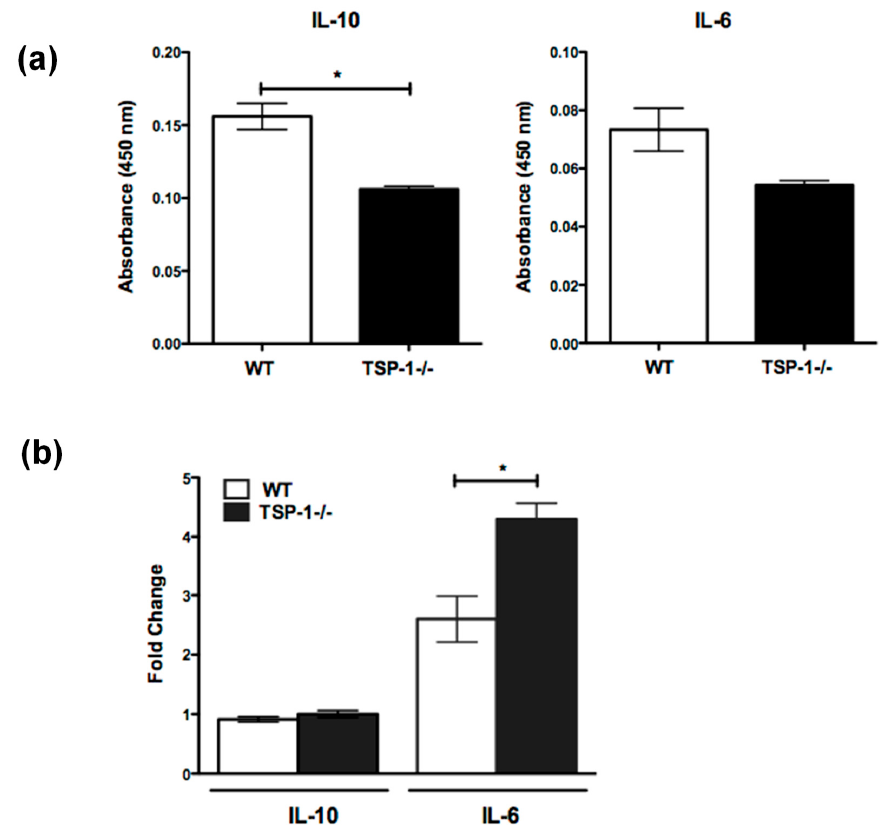
Figure 4. Cytokine secretion by MZB cells from TSP1 − / − mice is altered. Sorted splenic MZB (CD43 − CD23 − CD21 + ) cells were cultured for three days in the absence ( a ) or presence ( b ) of apoptotic cells and cytosine–phosphate–guanine (CpG-B). Culture supernatants were evaluated for the levels of interleukins 10 and 6 (IL-10 and IL-6) using ELISA. Results show mean and standard error of the mean (SEM) values ( n = 3 per strain from two independent sorts). In the case of stimulated MZB, results are presented as cytokine levels relative to unstimulated cells; * p < 0.05.